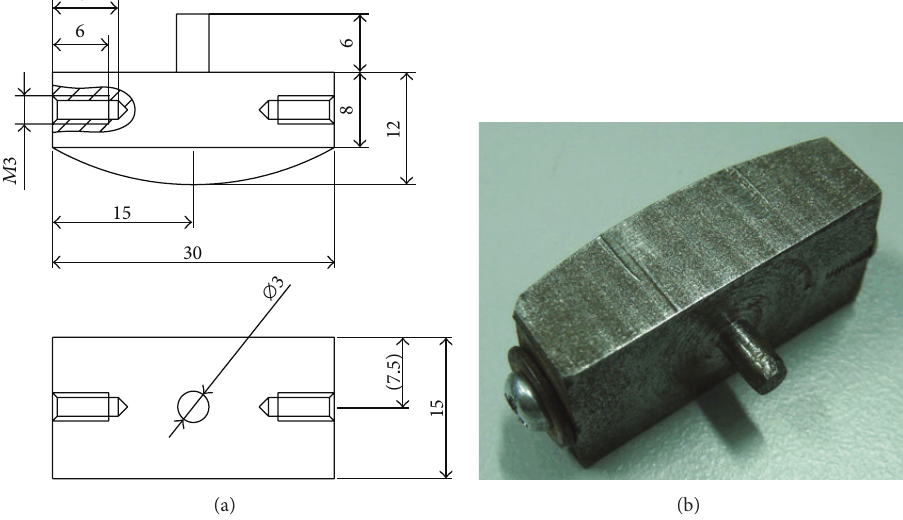
Figure 4: Dimensional drawing and photograph of the special fixture developed to hold the rape stalk.